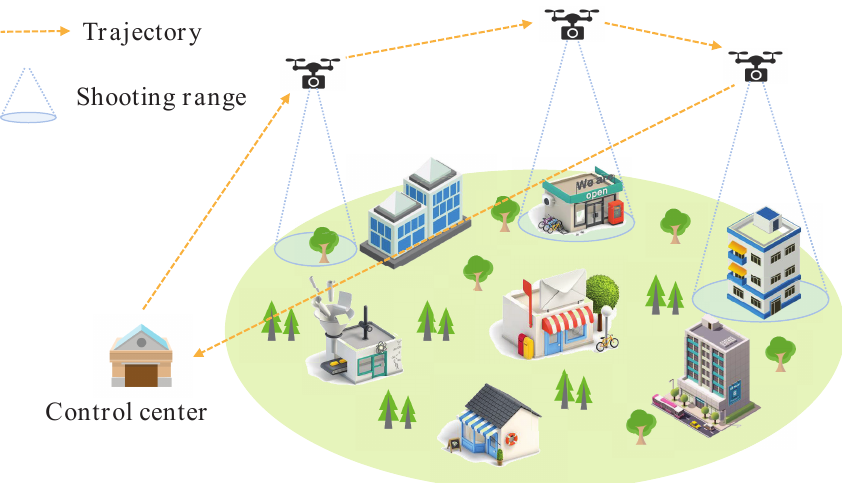
Figure 1. A diagram of a UAV-assisted WCSN